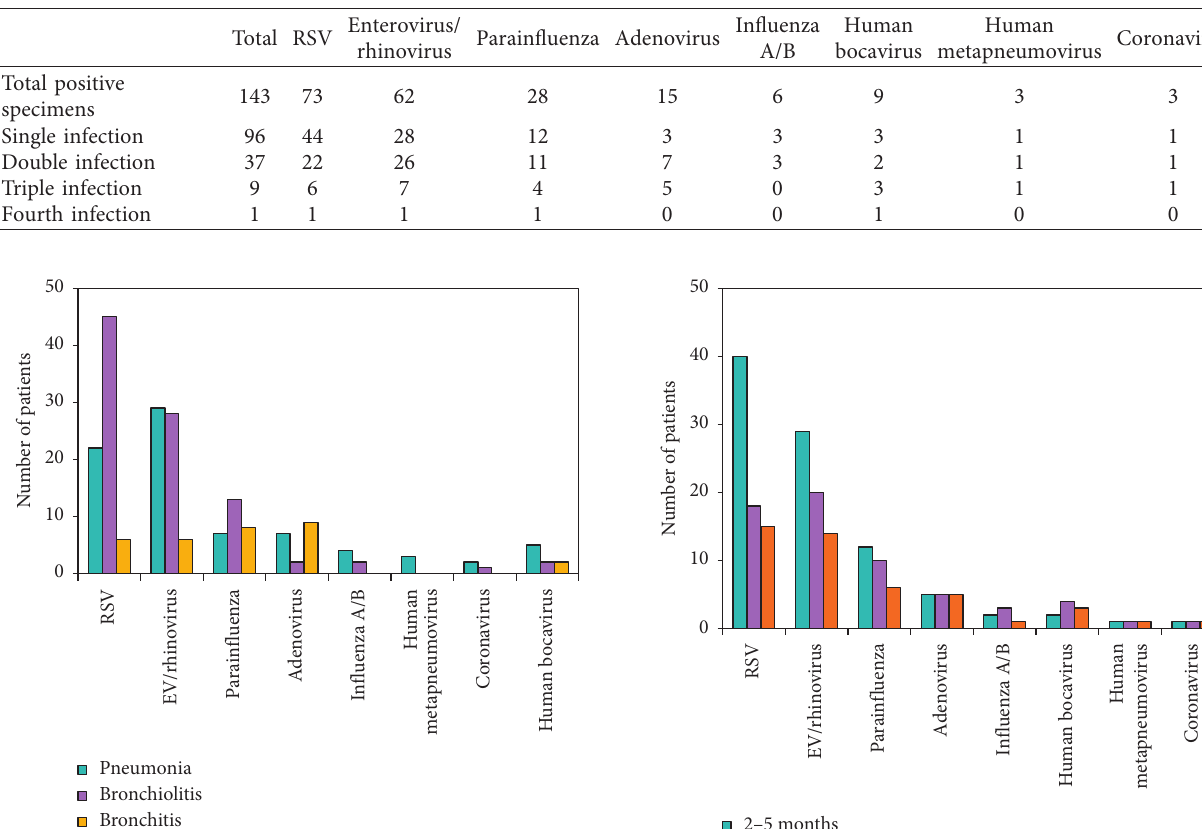
Figure 1: Bar graph showing the respiratory viruses detected in each age group. The most abundant viruses were respiratory syncytial virus (RSV) and enterovirus (EV)/rhinovirus (Rhi), which mainly infected patients in the 2–5 months group. ∗ p < 0 . 001.